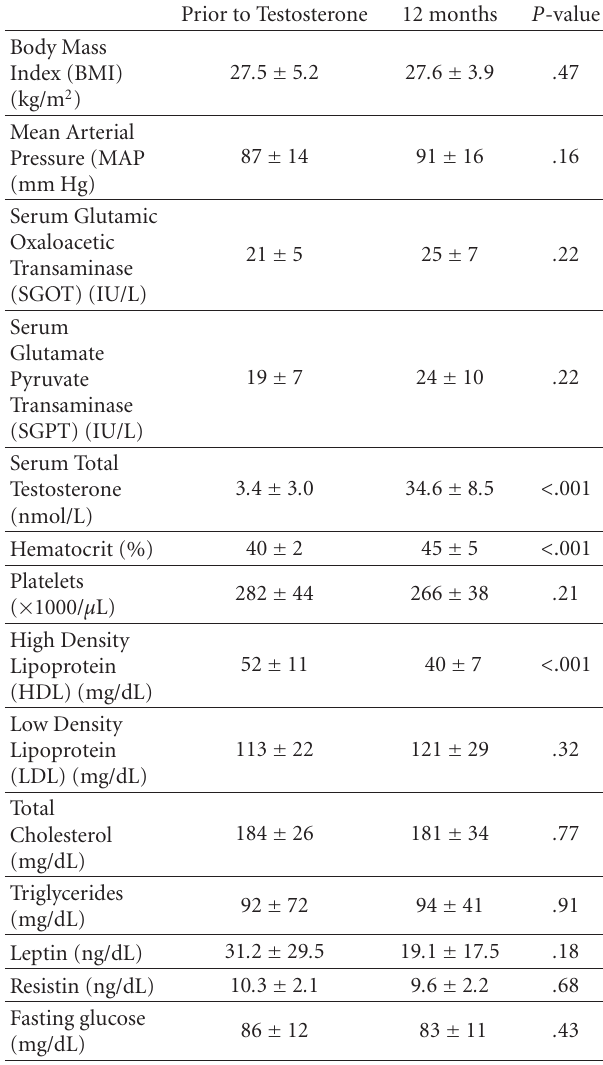
Table 2: Biochemical changes in response to 12 months of testos- terone therapy in female-to-male transsexuals, including changes in lipid profile and markers of insulin resistance. Mean ± SEM, N = 12 unless